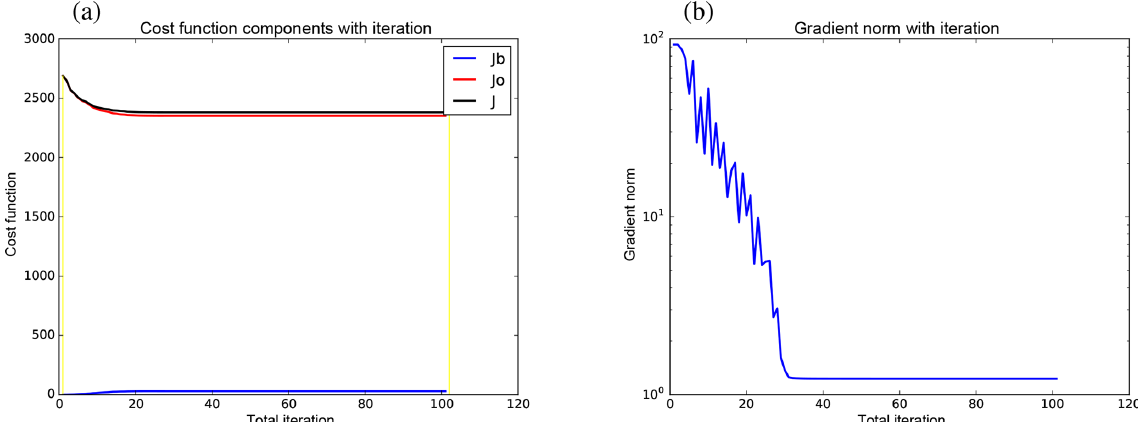
Figure 9. Cost function statistics as a function of inner-loop iteration from the seventh cycle of the GB + VR + experiment. Panel (a) shows the cost function contributions: J b (blue), J o (red), and J = J b + J o (black). The yellow lines mark the 0th and 100th (the maximum iteration) iterations. Panel (b) shows the norm of the cost function gradient. ˜ ρ (cid:48) − δ b (cid:48) covariances, Fig. 7c and i, have similar in the δ patterns but are larger in panel (c) for similar